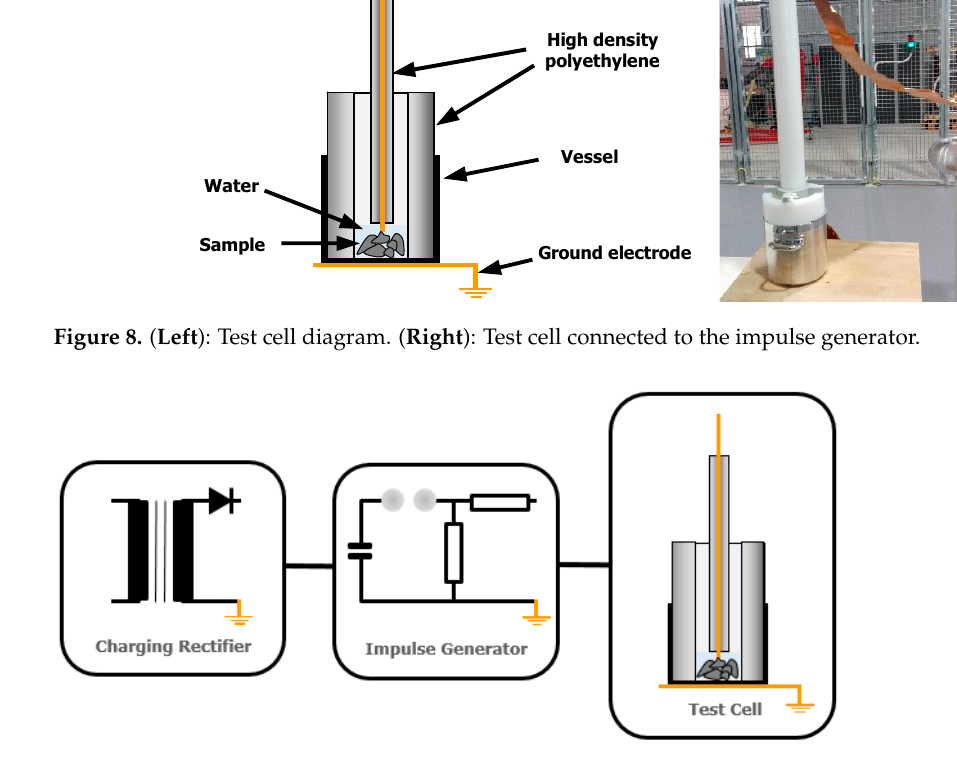
Figure 9. Diagram of the pulse generator and coupled test cell.